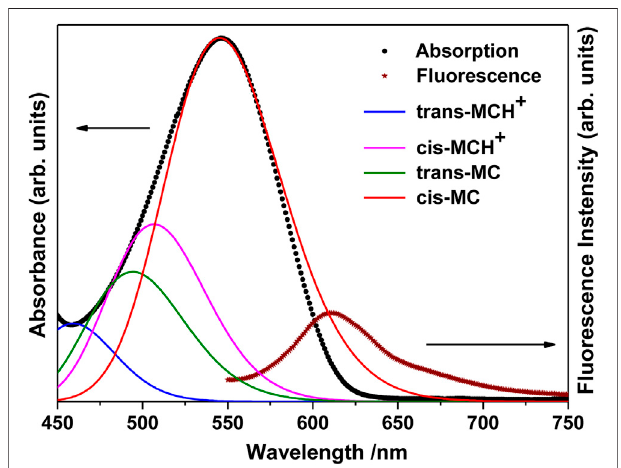
FIGURE 2 | Absorption (Concentration: 10 μ M) and fl uorescence (Concentration: 0.1 μ M) spectrum of merocyanine in acetonitrile solution. The computed absorption spectrum of trans -MCH + , cis -MCH + , trans -MC, and cis -MC in acetonitrile solvent is scaled and red-shifted by 32 nm to have a realistic resemblance with the experimental